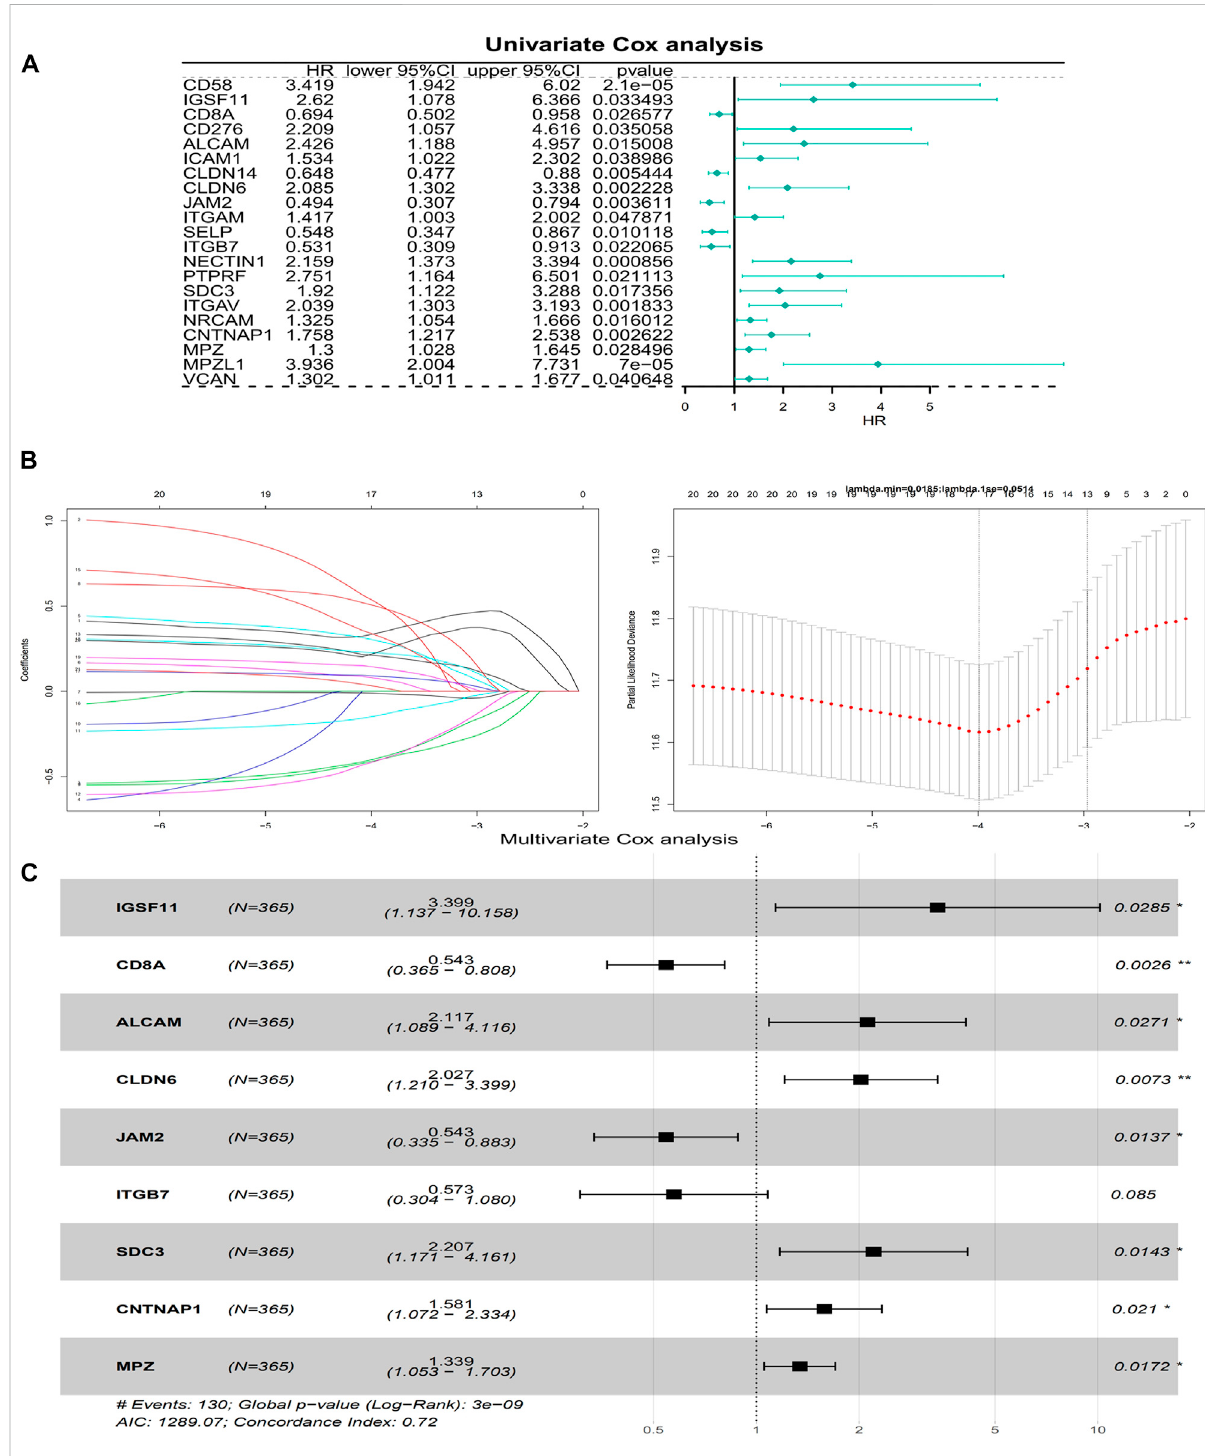
FIGURE 4 Building of a risk model. (A) A forest plot of Univariate Cox regression analysis. HR is the hazard ratio and Lower/Upper 95% CI is the 95% con fi dence interval of the value at risk. (B) Gene coef fi cient plot and cross-validation error plot of LASSO regression analysis. (C) A forest plot of Multivariate Cox regression analysis. HR is the hazard ratio and Lower/Upper 95% CI is the 95% con fi dence interval of the value at